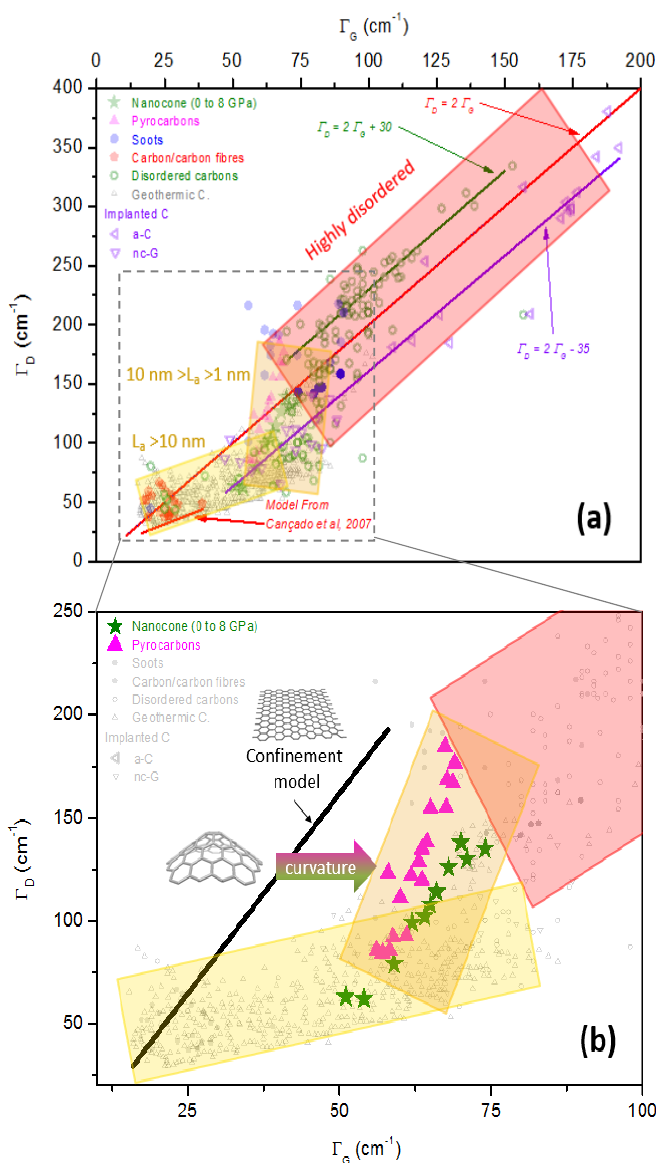
Figure 25. Г D versus Г G plot. ( a ) For a large variety of disordered aromatic carbons; ( b ) Zoom with suggestion of both phonon confinement and curvature effects.